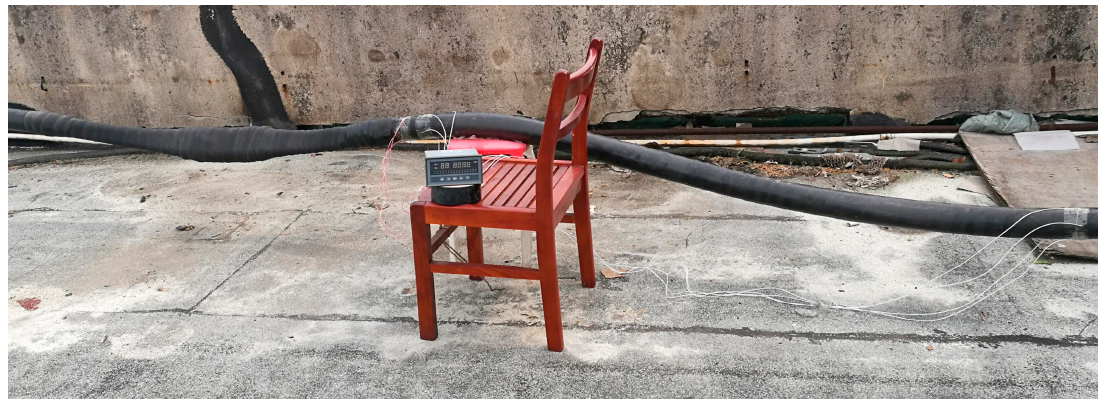
Figure 11. Configuration of the temperature-rise test.